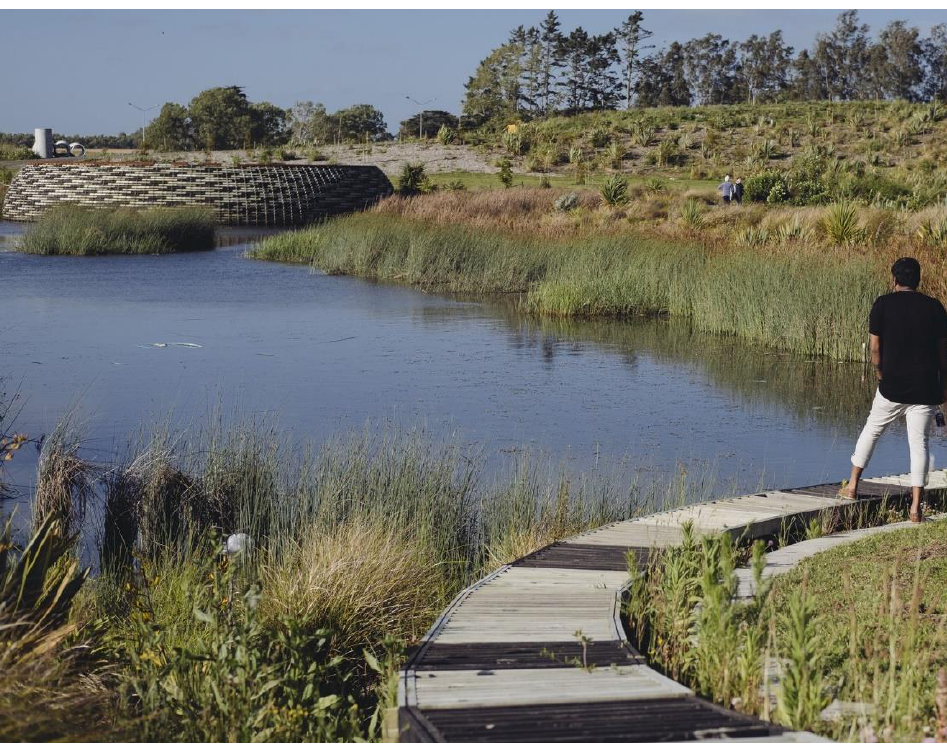
Figure 4. Kopupaka Reserve, Aotearoa New Zealand.